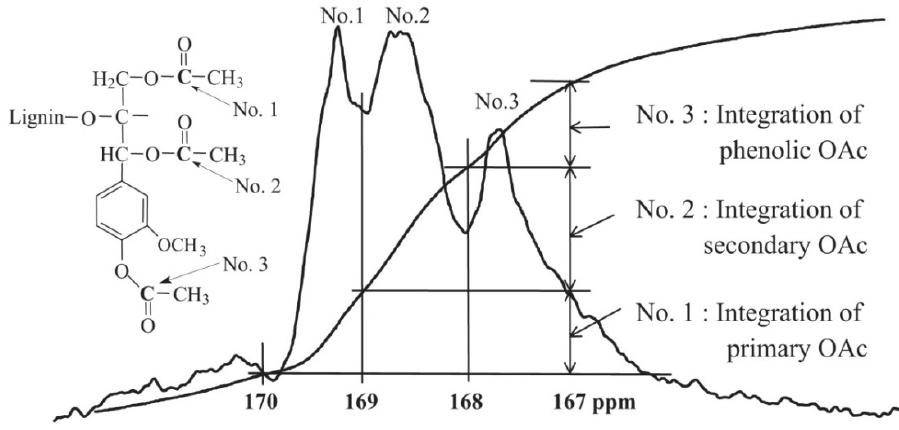
Figure 3. Quantitative evaluation of hydroxyl groups by 13 C NMR spectra of acetylated lignin. (Reprinted from [36]. Copyright 2011